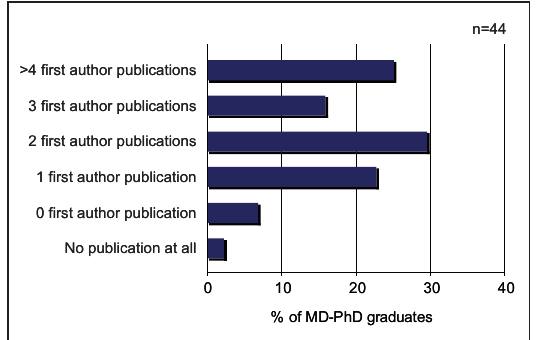
Publication record resulting from the PhD research